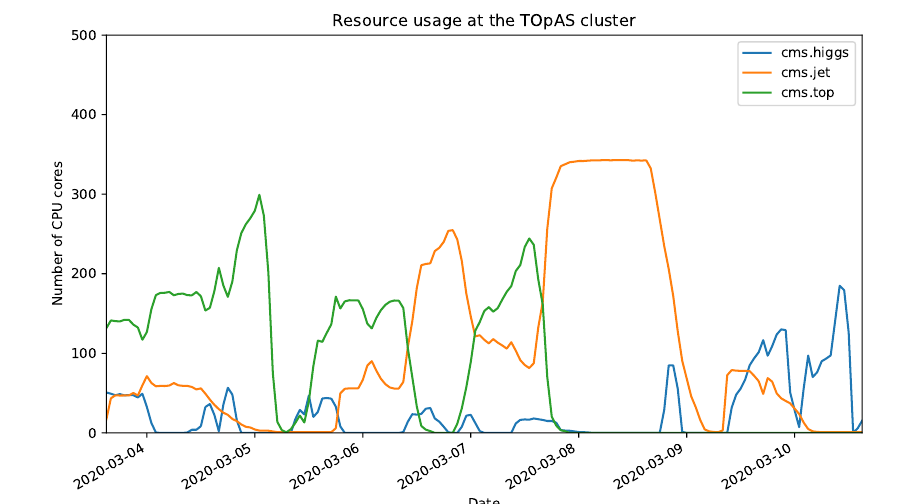
Figure 3. Utilization of the TOpAS cluster by jobs submitted from end-users at the institute for experimental particle physics in a seven-day period. Workloads typically occur in bursts, leading to times, where the resources are not fully utilized for end-user analyses. The workloads are shown split by accounting group, which corresponds to the field of research the users are involved in.